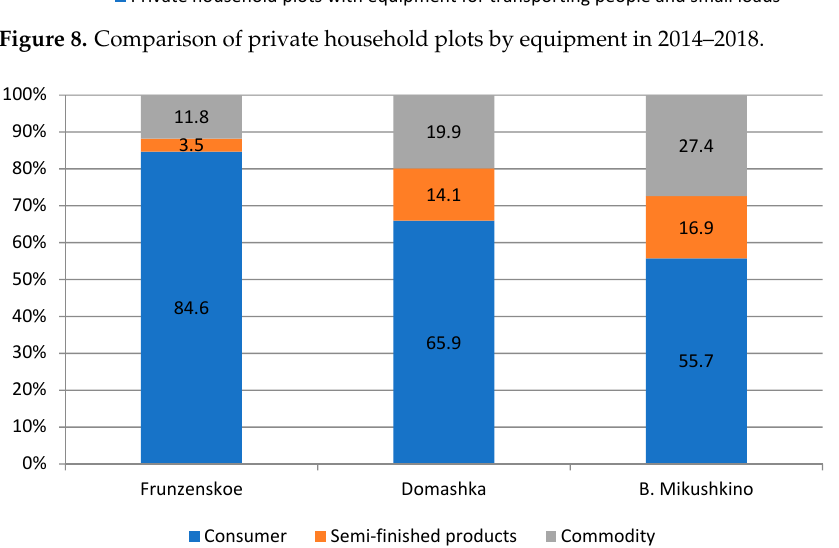
Figure 9. Comparison of private household plots by the level of marketability in 2014–2018. The following results were obtained on the livestock for the study period. In Frun- zenskoye and Domashka, there are mainly private household plots without livestock (70.5 and 60.6% respectively), and in B. Mikushkino they account for 35.7% (Figure 10).